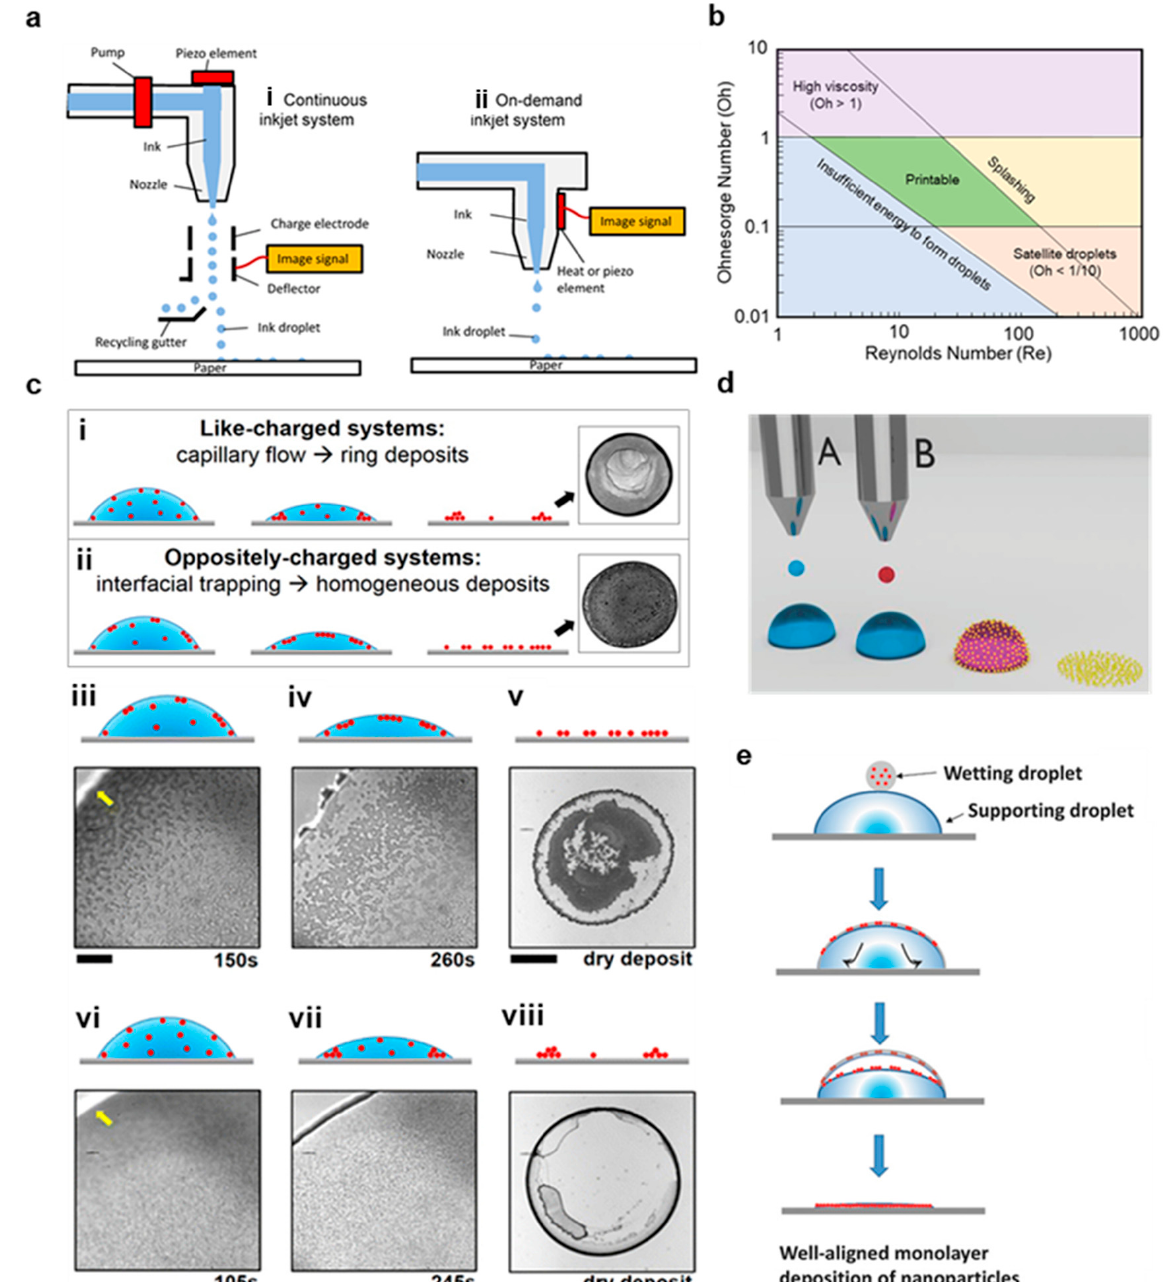
Figure 5. Roll-to-roll inkjet printing for hybrid bioelectronics. ( a ) Illustration of CIJ ( left ) and DOD ( right ) inkjet printing techniques. (reprinted with permission from Micromachines (2017), 8(6), 194. Copyright 2017, MDPI). ( b ) Reynolds number and Ohnesorge numbers that yield a high-quality inkjet deposition. Weber numbers can be calculated based on the